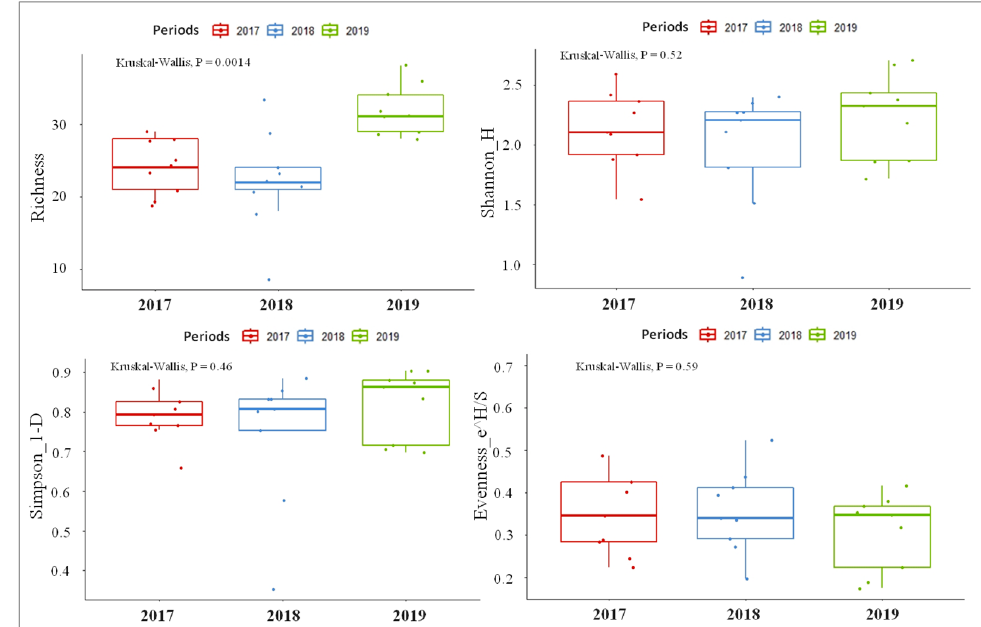
Figure 5. Species richness and Biodiversity indices (Shannon_H, Simpson_1-D, and Evenness_e^H/S) of macroinvertebrates were measured for each period of sampling. To facilitate the comparison of patterns in different diversity measures, parameter values are displayed in the Y-axes relative to the highest value for each period. Significance levels are also shown on the graphs for these different periods.